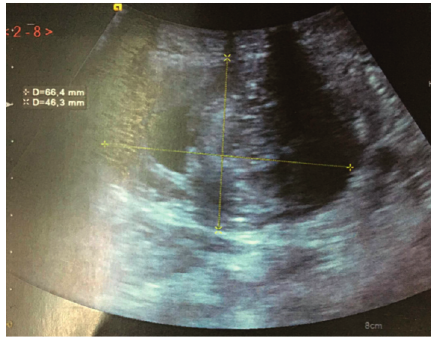
Figure 1: Abdominal ultrasound showing a left flank mass.